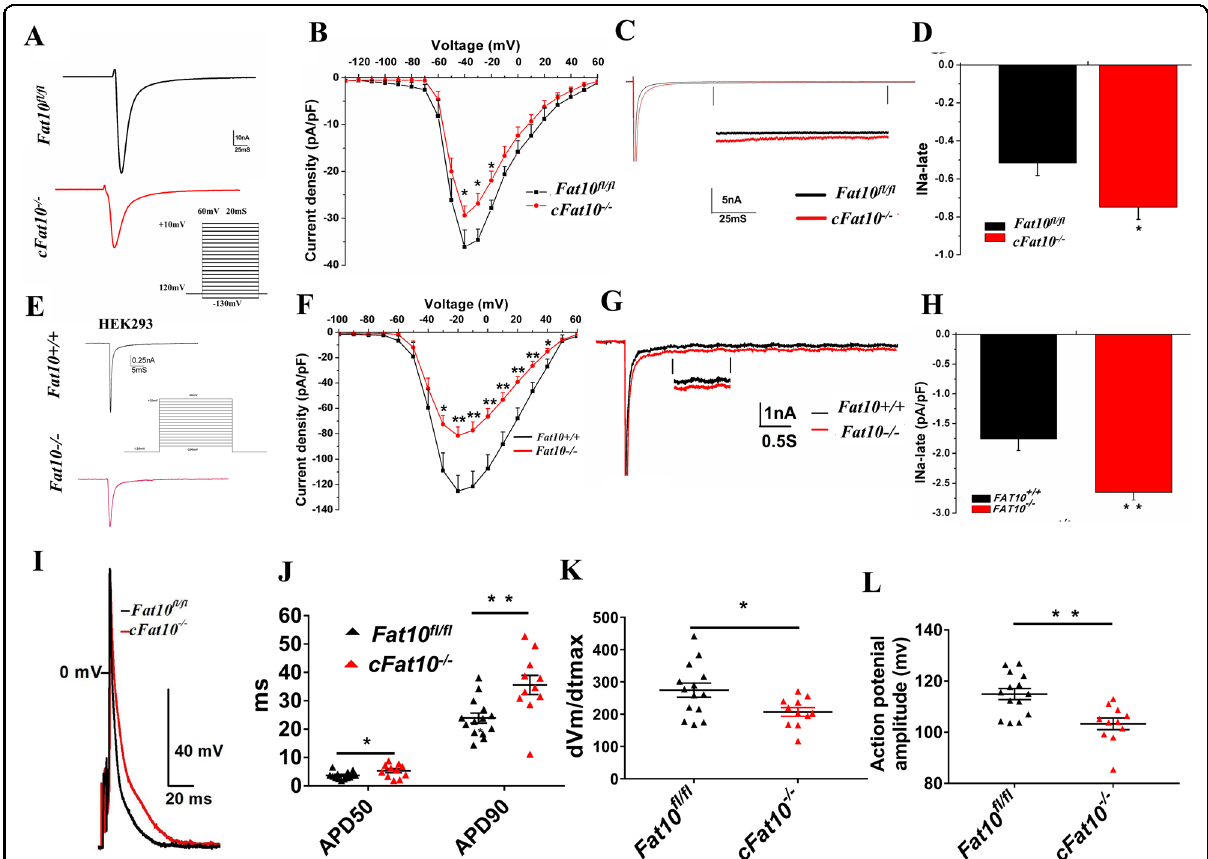
Fig. 3 Sodium current ( I Na ) and action potentials (AP) of cFat10 − / − cardiomyocytes. A , B Peak I Na in ventricular myocytes isolated from cFat10 − / −